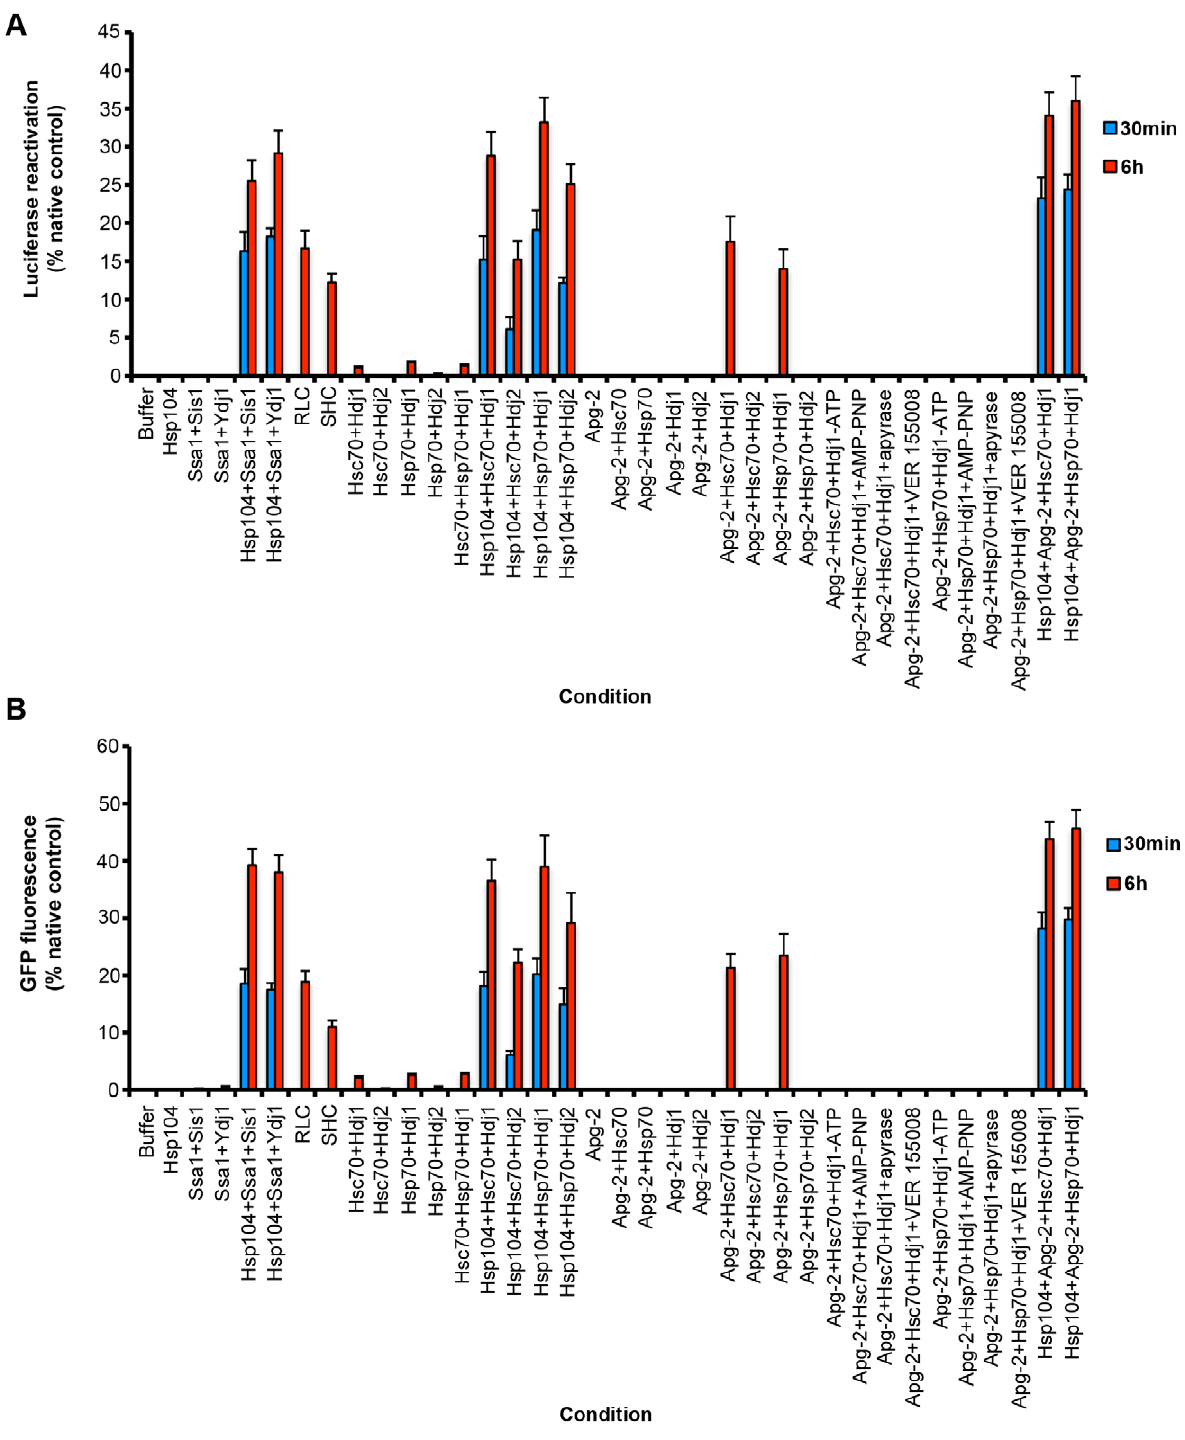
Figure 3. Pure Hsp110, Hsp70 and Hsp40 drive protein disaggregation. ( A, B ) Urea-denatured luciferase aggregates (50 nM) ( A ) or heat- denatured GFP aggregates (0.45 m M) ( B ) were incubated for 30 min (blue bars) or 6 h (red bars) at 37 u C in buffer plus ATP (5 mM) and ATP- regeneration system without or with the indicated combination of Hsp104 (1 m M), Ssa1 (1 m M), Ydj1 (1 m M), RLC (10 mg/ml), SHC (10 mg/ml), Hsc70 (1 m M), Hdj1 (1 m M), Hdj2 (1 m M), Hsp70 (1 m M) and Apg-2 (1 m M). In the indicated reactions, ATP was omitted or replaced with AMP-PNP. Alternatively, ATP was included but the ATP-regeneration system was replaced with apyrase. The small molecule inhibitor VER 155008 (100 m M) was included in the indicated reactions. Disaggregation and reactivation of luciferase was monitored by luminescence. Luminescence measurements were converted into reactivation yield (% of the maximum recoverable luciferase activity) by comparison to the luminescence of known quantities of soluble, native luciferase ( A ). Disaggregation and reactivation of GFP was monitored by fluorescence. Fluorescence measurements were converted into reactivation yield (% of the maximum recoverable GFP fluorescence) by comparison to the fluorescence of known quantities of soluble, native GFP ( B ). Values represent means 6 SEM (n=3).